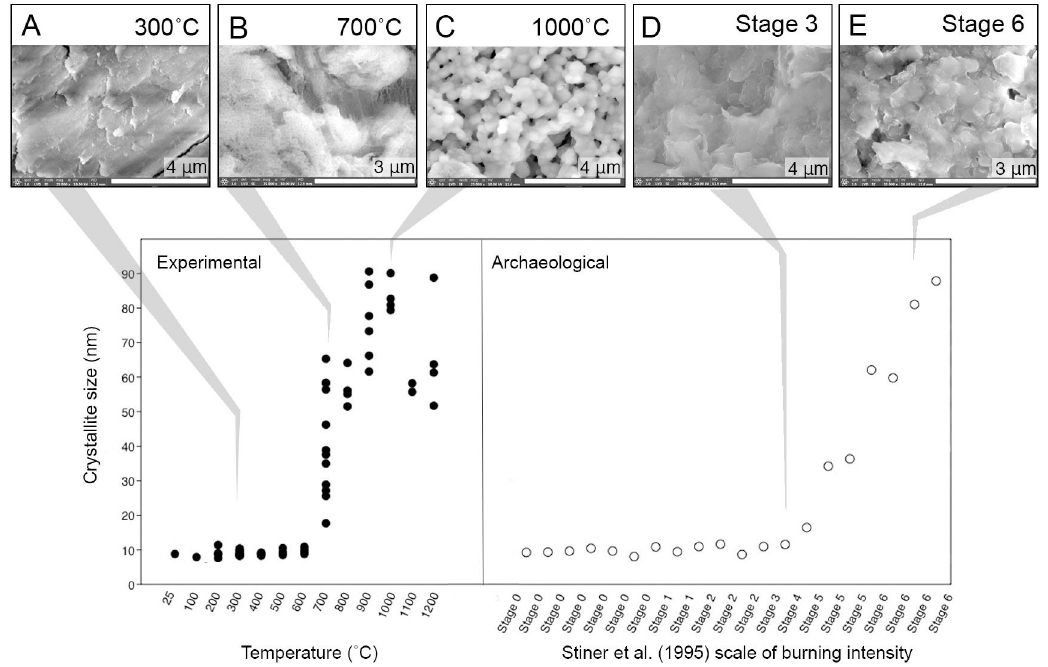
Fig 7. XRD results of averaged crystallite size (nm) alongside selected SE images of experimental modern (A-C) and archaeological (D-E) bone to visualize the changes to crystal shape with heat alteration. Images A and D highlight the small, platelike shape of bioapatite burned to at least 300˚C. Images B and C, both modern, demonstrate morphological range of bones burnt above 700˚C, both of which are fully calcined and are considered Stage 6 on the Stiner et al. [27] scale of burning intensity. The initial growth of hexagonal crystals ~700˚C (B) and eventual equaixing and further growth of crystals above 900˚C (C) are clearly seen in images B and C, and when compared to the archaeological sample of a fully calcined Stage 6 bone (E), the bioapatite crystal morphology corresponds to the size and shape of experimental bones burned above 900˚C. Magnification and instrument details described in S1 Appendix.